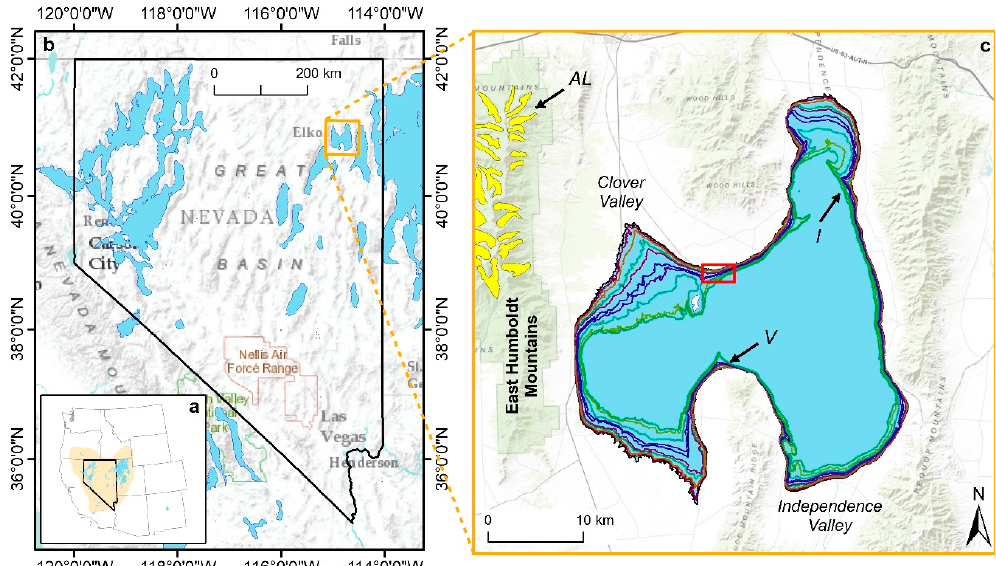
Figure 1. ( a ) Inset map showing the state of Nevada (bold outline) in the western US. The beige polygon delineates the Great Basin, and blue polygons represent pluvial lakes [7]; ( b ) Enlarged view of Nevada and pluvial lakes during the late Pleistocene. The orange square highlights Lake Clover and represents the area of panel c; ( c ) Enlargement of the Clover and Independence Valleys that hosted Lake Clover. The extent of the lake at its highstand is shown in blue; mapped shorelines are shown as lines. The red box highlights the Tobar transect study area in Figure 2. Yellow polygons in the East Humboldt Mountains are reconstructed alpine glacier outlines for the Last Glacial Maximum. “AL” denotes the type locality for the Angel Lake Glaciation [15]. “V” and “I” indicate locations at Ventosa and in the northeastern Independence Valley (respectively) where the age of the highstand beach ridge was previously constrained by 14 C dating [14].